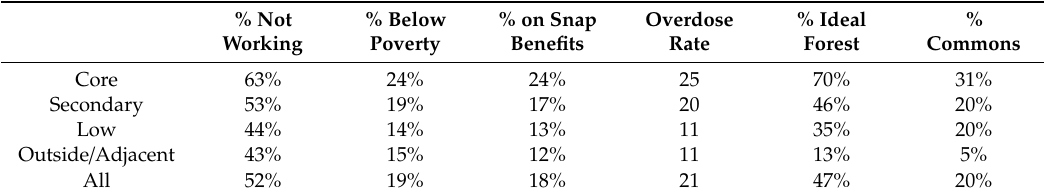
Table 5. Mean scores of other biophysical and socioeconomic variables for registered ginseng dealers clustered by the probability of purchasing non-ginseng medicinal plants.